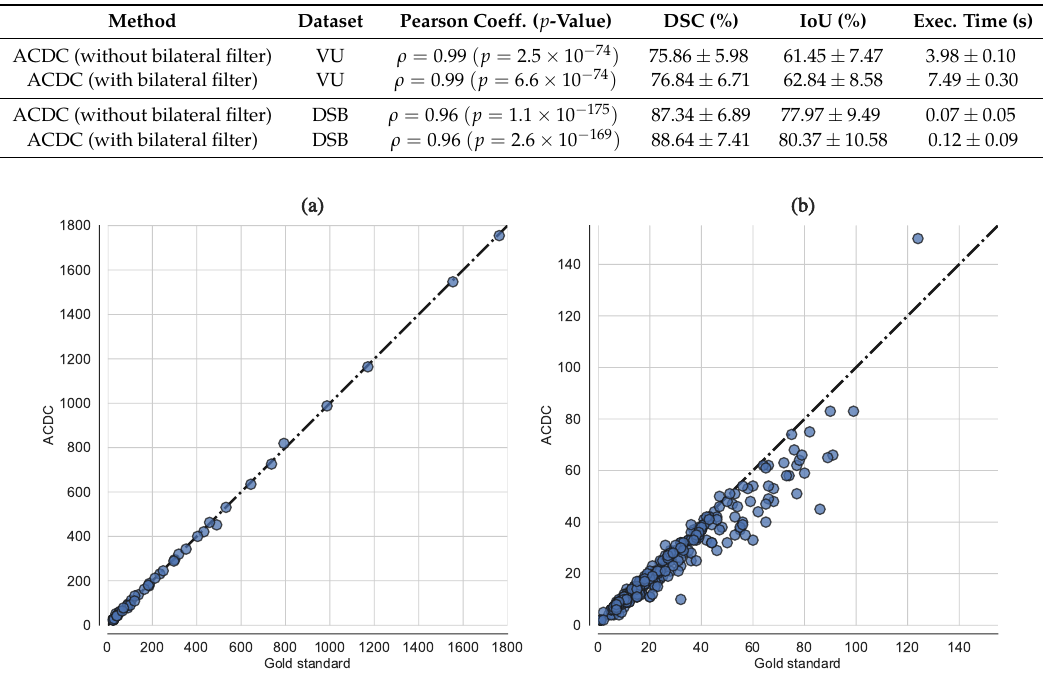
Figure 9. Scatter plots depicting ACDC results compared to the gold standard in terms of cell nuclei counting in the case of: ( a ) time-lapse fluorescence images from the VU dataset; ( b ) small fluorescent nuclei images from the DSB dataset. The equality line through the origin is drawn as a dashed